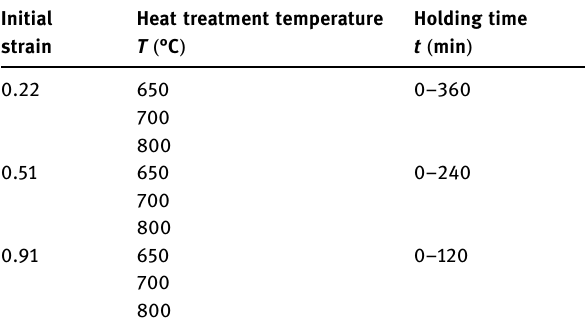
Table 1: Process parameters of heat treatment